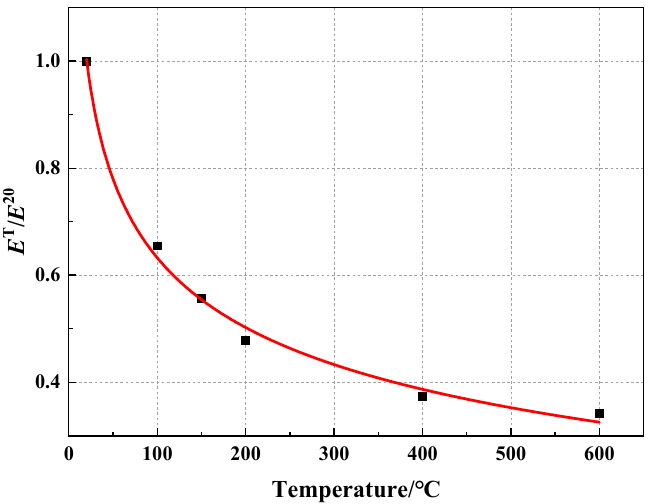
Figure 11. Elastic modulus ratio changes with temperatures.